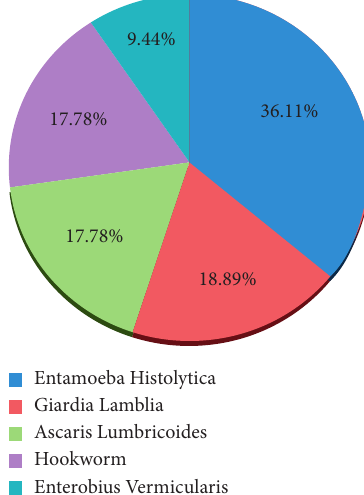
Figure 2: Proportion of isolated intestinal parasite species among infected children attending primary schools in pastoral commu- nities, Mieso-Mulu district, Sitti Zone, Eastern Ethiopia,